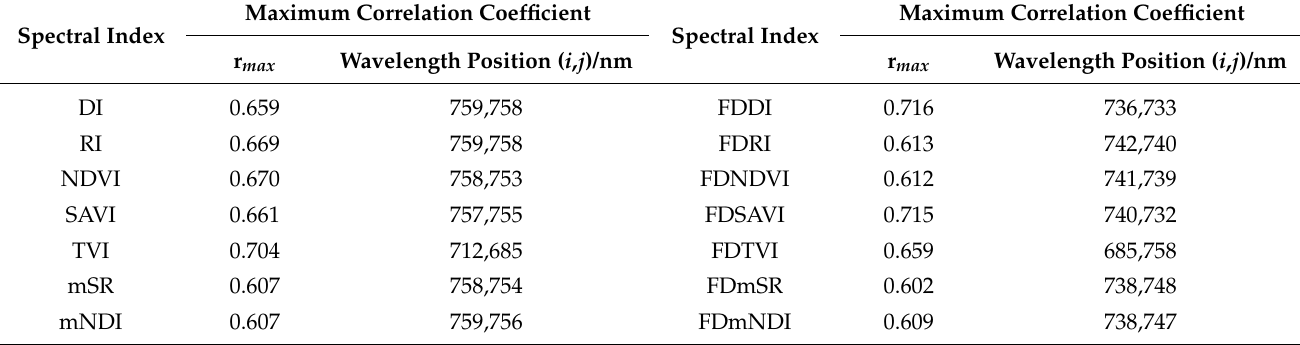
Table 3. The maximum value and wavelength position of correlation coefficient between spectral index and leaf area index.